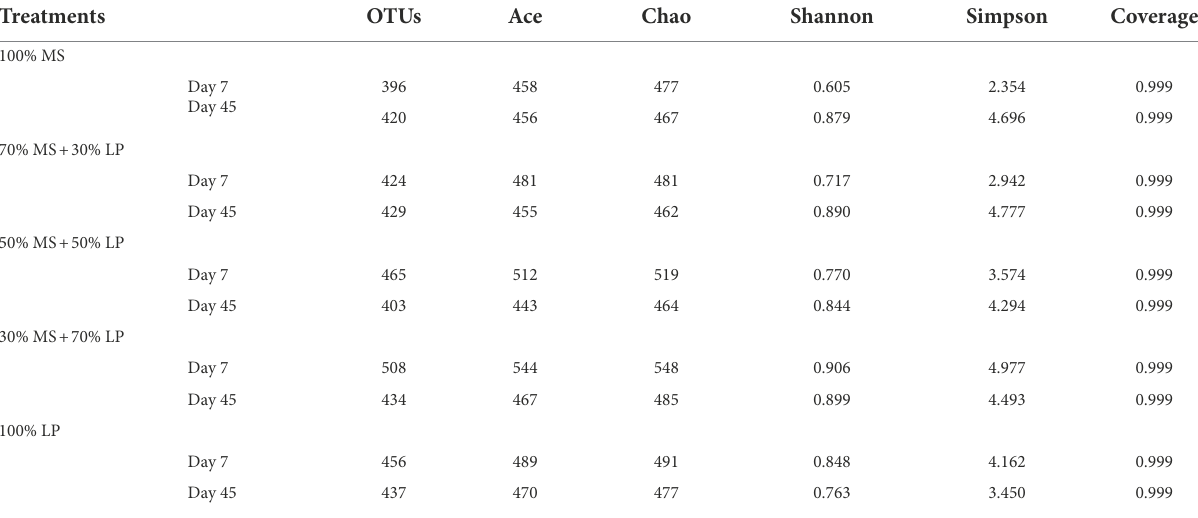
TABLE 4 Diversity and richness of the bacterial microbiota of alfalfa ensiled with perennial ryegrass.